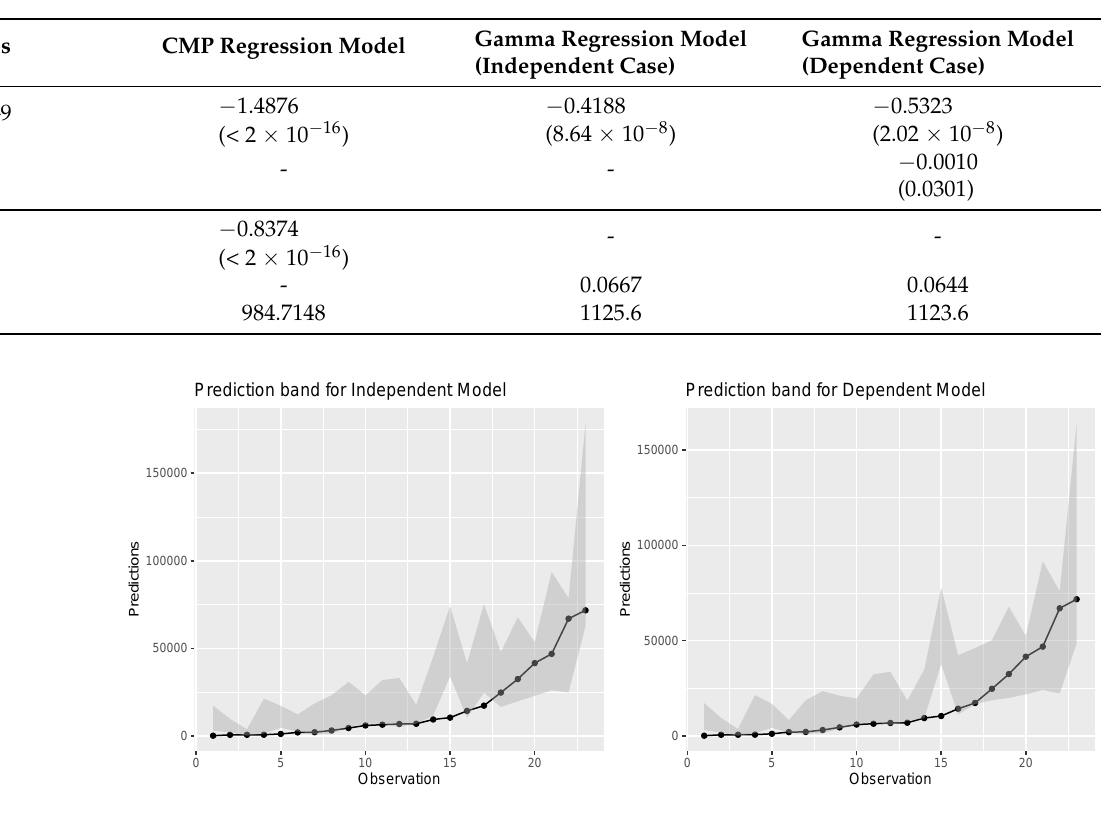
Figure 1. Prediction band for the test data under independent model and dependent